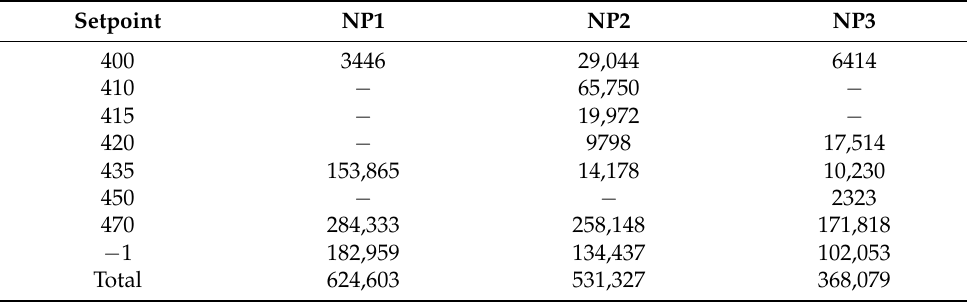
Table 2. Total number of data points available for NP1 through NP3. The setpoints 400 through 470 are continuous on the top and bottom of the print, while the points marked with a − 1 are when the processing parameters were not used in the predictive